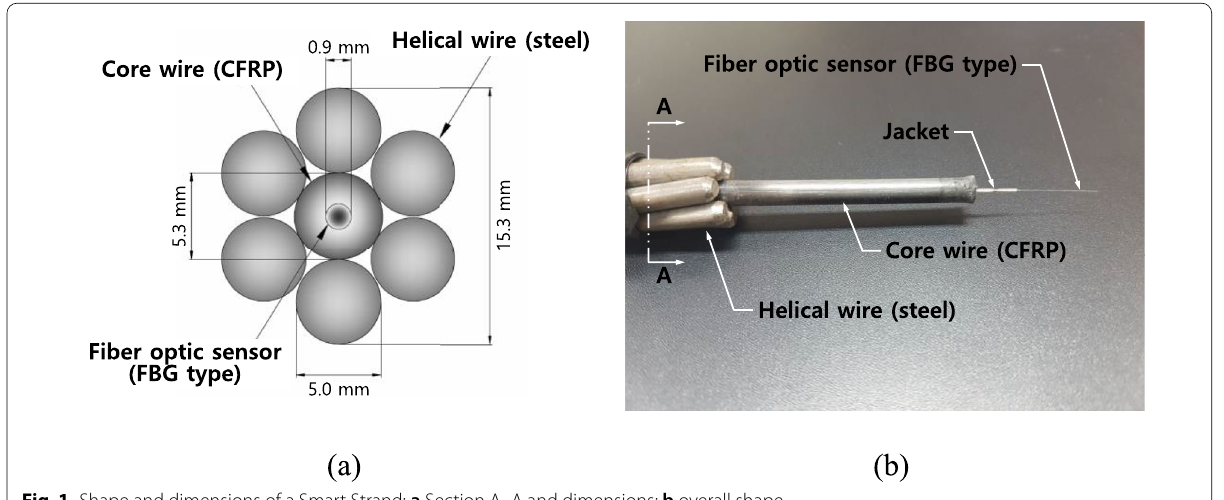
Fig. 1 Shape and dimensions of a Smart Strand: a Section A–A and dimensions; b overall